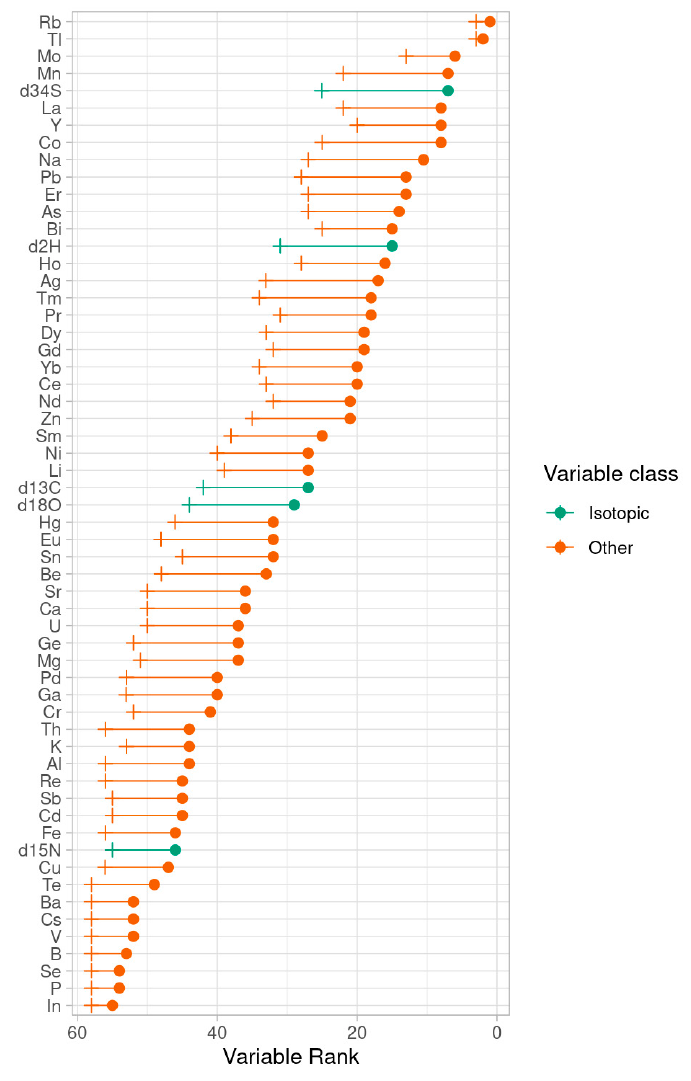
Figure 3. Ability of the developed model to classify origin correctly.